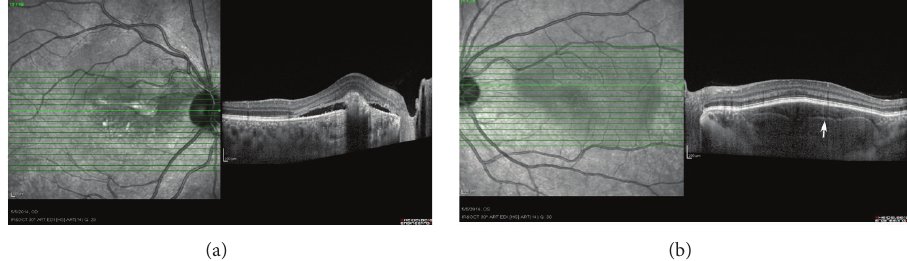
Figure5:(a)EDI-OCTrevealedouterretinalabnormalityandSRFduetoCNVoverlyingthetumorintherighteye.(b)Sponge-likechoroidal lesion with horizontal hyperreflective lines (arrow) inside the tumor, thinning of choriocapillaries, and large choroidal vessels in the left eye (b).